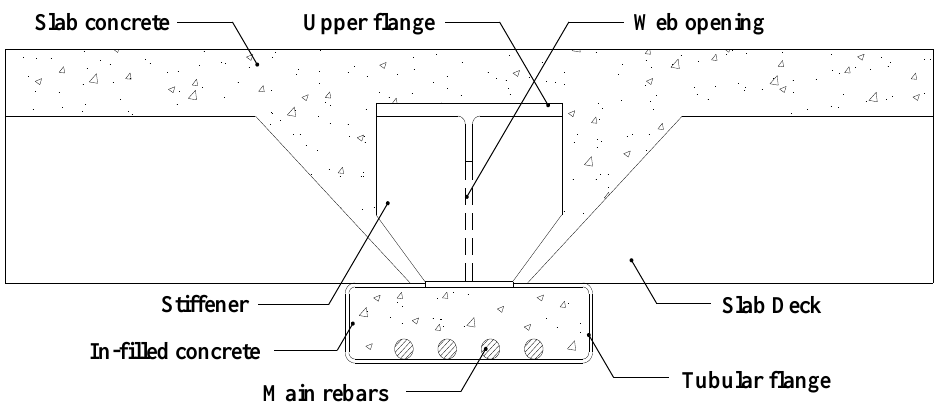
Figure 2. Composite beam section.